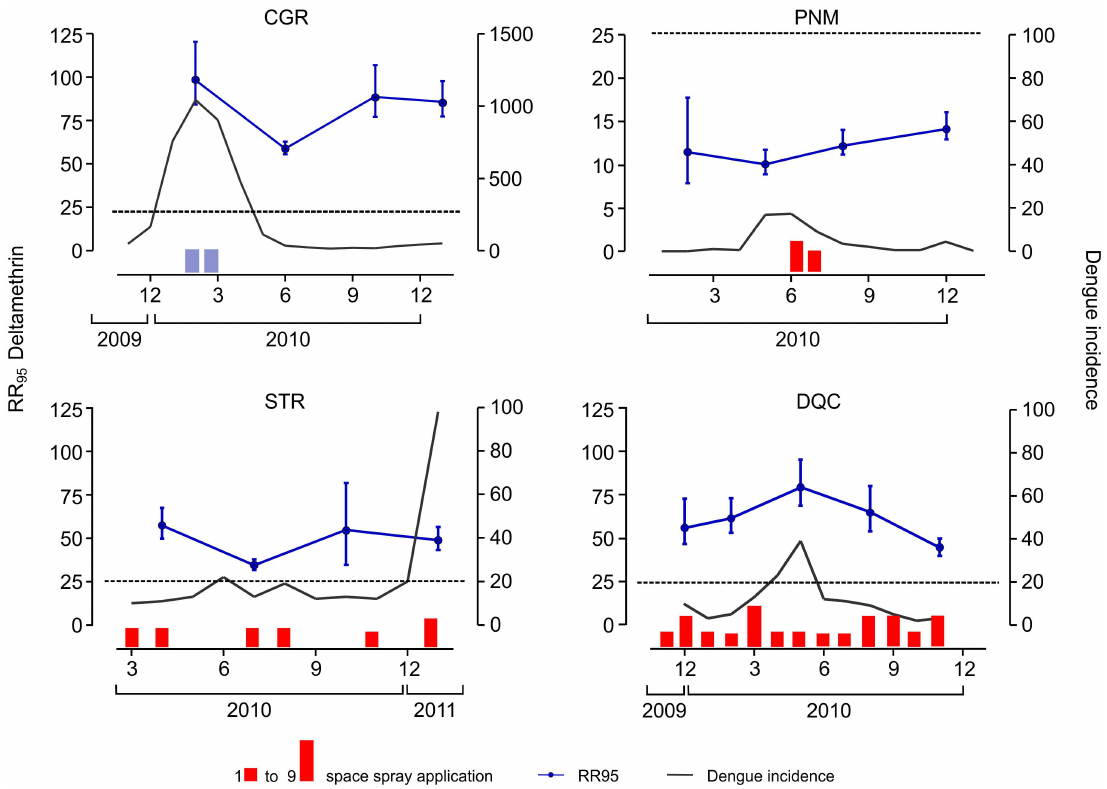
Fig 4. Temporal evaluation of deltamethrin susceptibility/resistance status of adult females from four Brazilian Ae . aegypti populations: Campo Grande/MS (CGR), Parnamirim/RN (PNM), Santare´m/PA (STR) and Duque de Caxias/RJ (DQC). Each point indicates the Resistance Ratio (RR 95 ) and the 95% confidence interval. Bars represent the number of deltamethrin (red) and malathion (blue) space spray applications conducted monthly in each municipality, varying between 1 and 9. The dashed line refers to an arbitrary value of 25.0, included in the figure to facilitate visualization of differences in RR among populations (note that y-axis scale, referring to deltamethrin RR 95 , is different for PNM population). Grey lines point to the dengue incidence in the period, expressed in number of cases/ 100,000 inhabitants. Note that the y-axis scale (Dengue incidence) of the CGR population was